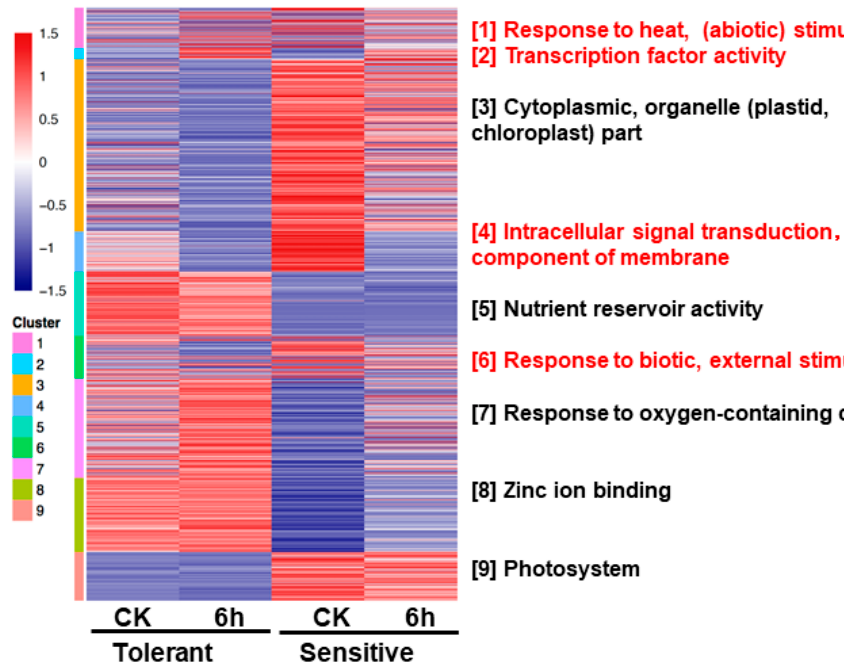
Figure 6. Mclust analysis of DEGs. Heatmap showing the expression pattern of DEGs specific to each group. Nine clusters were generated and named according to the highly significant GO terms found within them (based on q -value). Color bars represent enrichment ( q values) of GO terms of respective DEGs. CK, control.